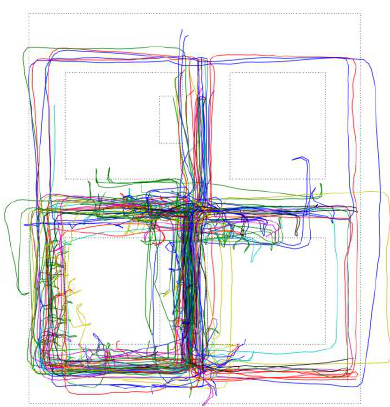
Figure 4. Traces acquired in 2 nd floor of university